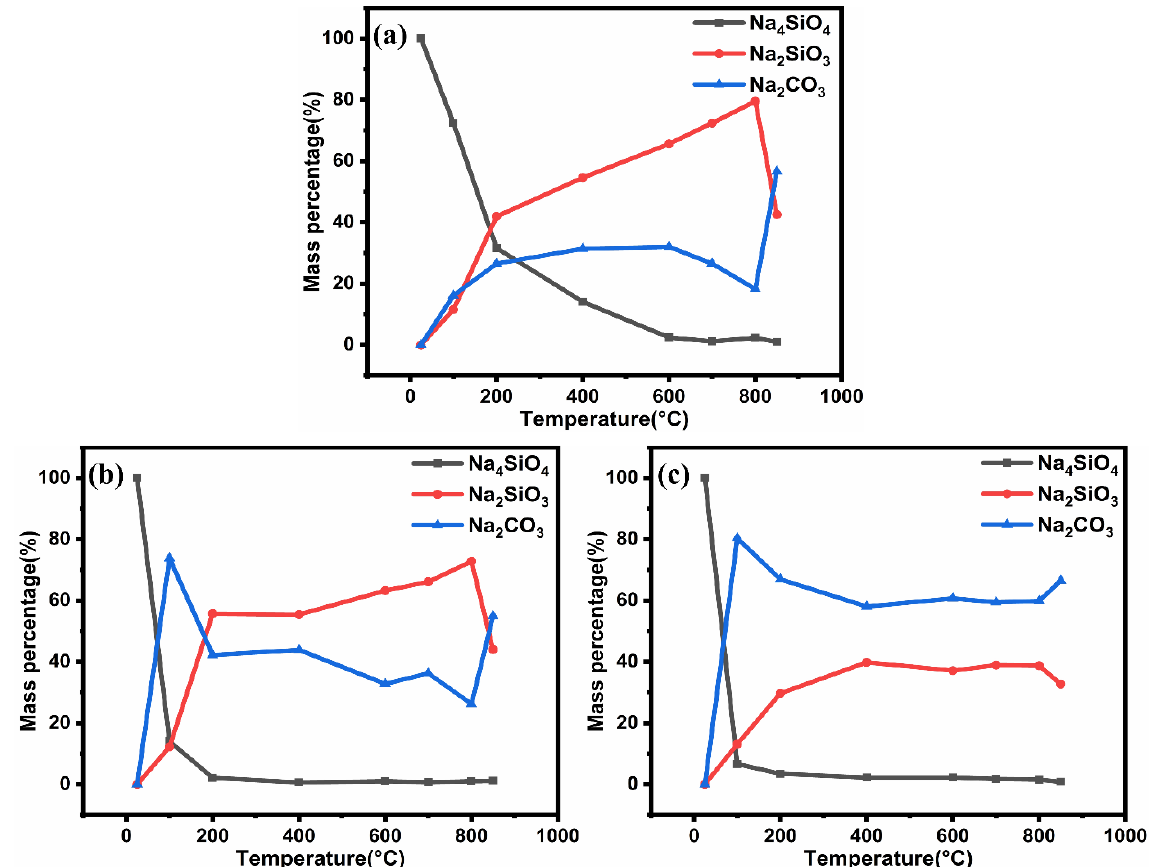
Figure 3. Mass percentage of different phases varying with temperature in in situ XRD characterization from 25 to 850 °C; ( a )P–Na, ( b )10(LiNa)90Na, and( c )10(LiNaK)90Na.